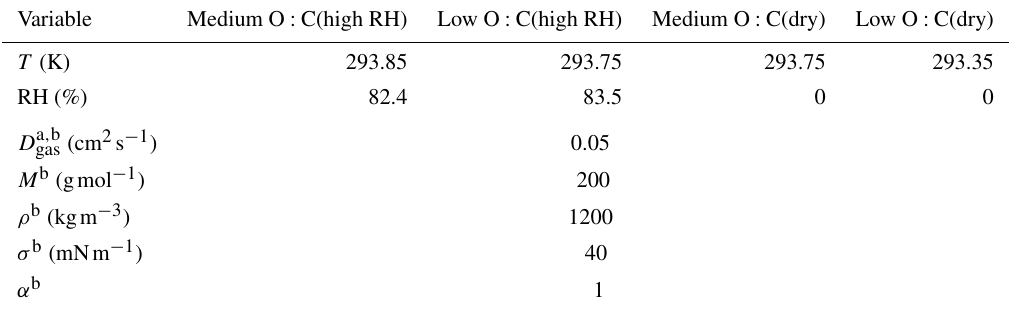
Table 1. The ambient conditions and properties of the organic compounds used in estimating the VD evap . The variables are, from top to bottom, temperature ( T ) during the evaporation, relative humidity (RH), gas-phase diffusion coefficient ( D g , org ), molar mass ( M ), particle- phase density ( ρ ), particle surface tension ( σ ) and mass accommodation coefficient ( α ). Rows that only have one value are the same in every